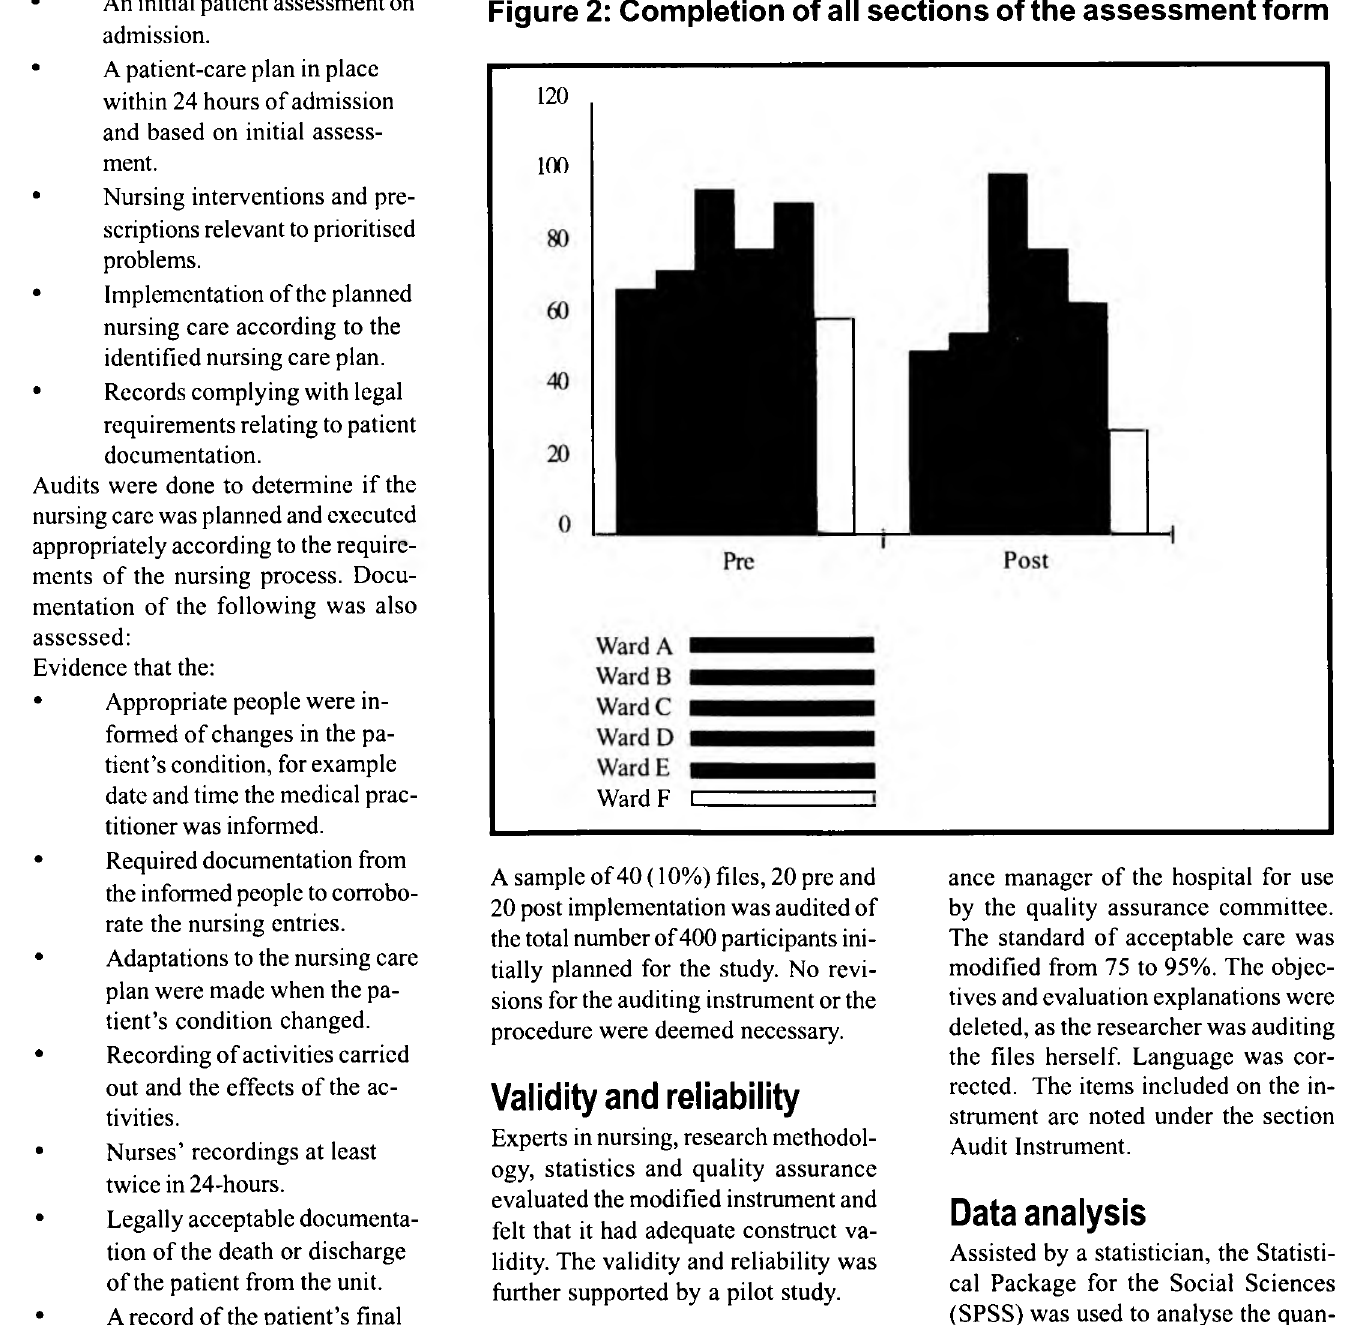
Figure 2: Completion of all sections of the assessment